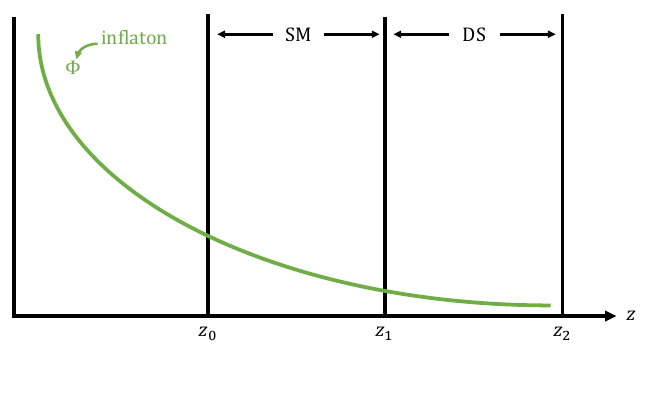
Figure 7 . AdS 5 picture corresponding to the 4d COFI theory setup in section